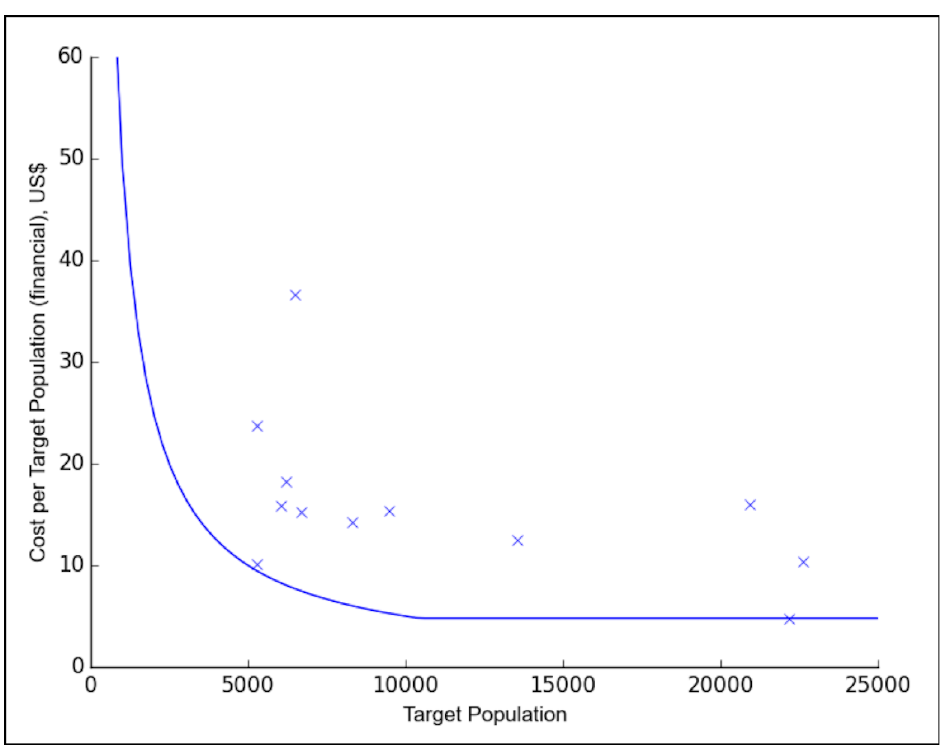
Fig 1. Target population and financial cost per dose in demonstration project countries. US$, United States dollars. Blue curve represents theoretical cost per girl in the target populationif countrieswere to spendexactly the amount providedby the Gavi demonstration project first year grant. The points (denotedby “x”) represent the actual financialcost per girl in the target population from Gavi demonstration projects.